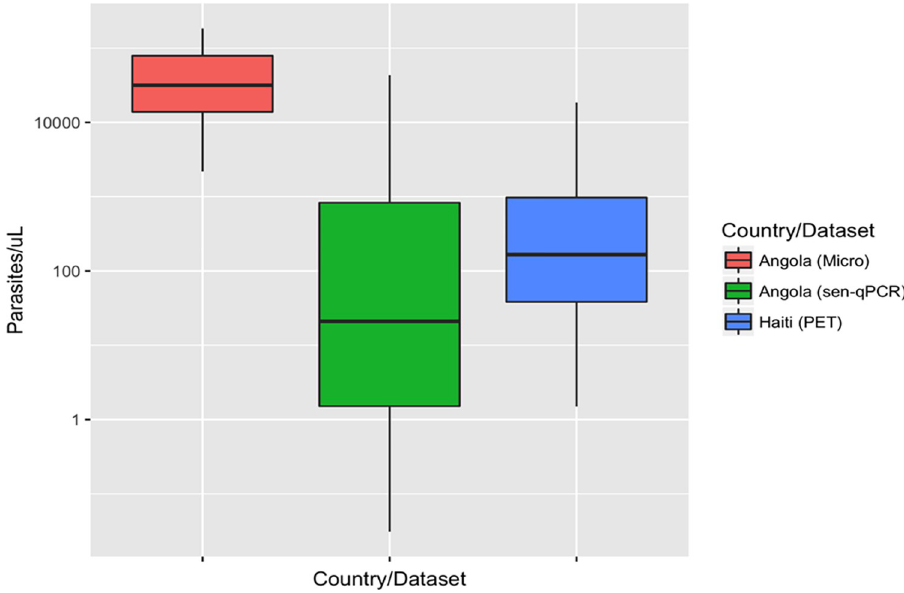
Fig 1. Parasitemia distribution for each countries’ dataset. For each study, parasite density depicted as parasites/ μ L blood. Middle bar = median. Upper box hinge = 75 th percentile. Lower box hinge = 25 th percentile. Upper whisker = largest value no further than 1.5 � IQR (inter-quartile range or distance from first and third quartiles) from the hinge. Lower whisker = smallest value at most 1.5 � IQR from the hinge.